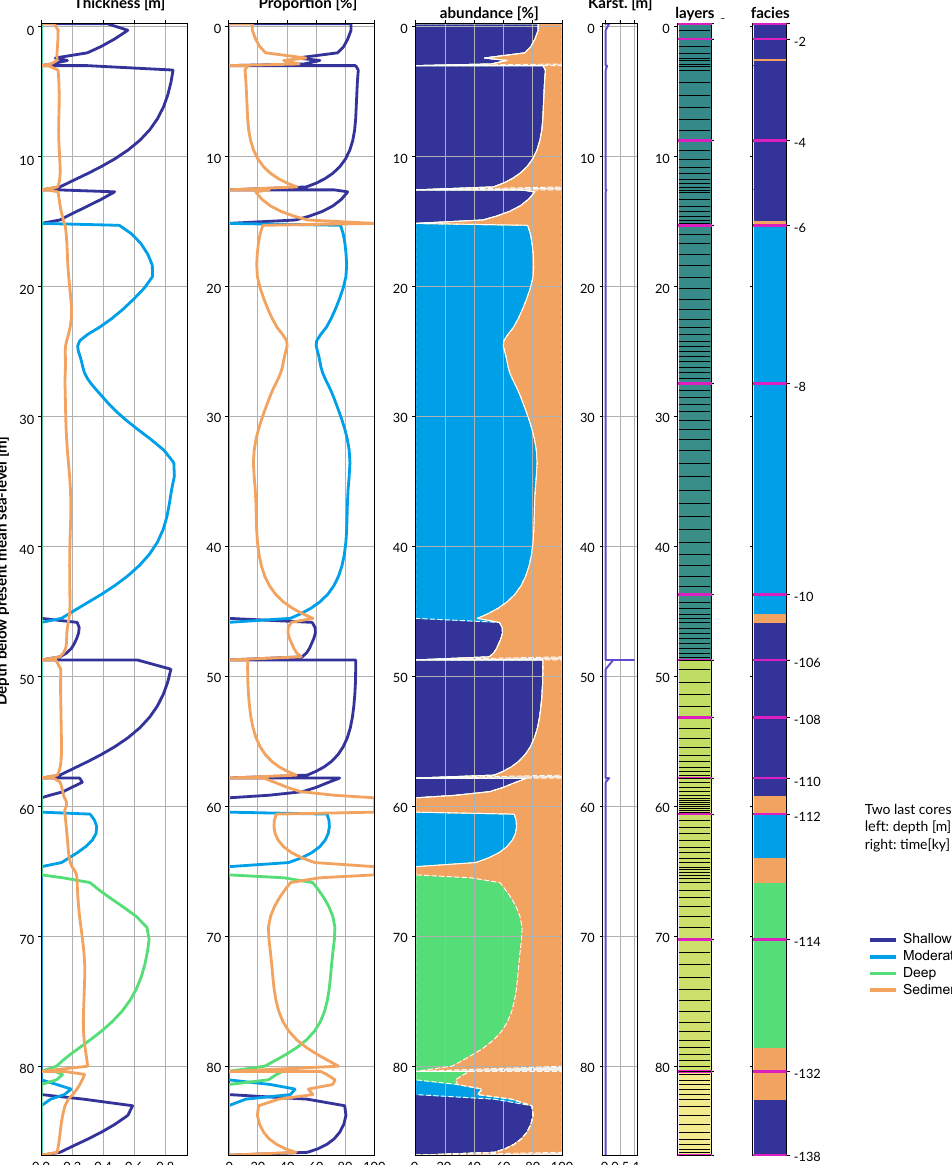
Figure 8. Simulated reef core reconstruction, showing the different stages of last interglacial reef growth in relation to sea level, karstification and